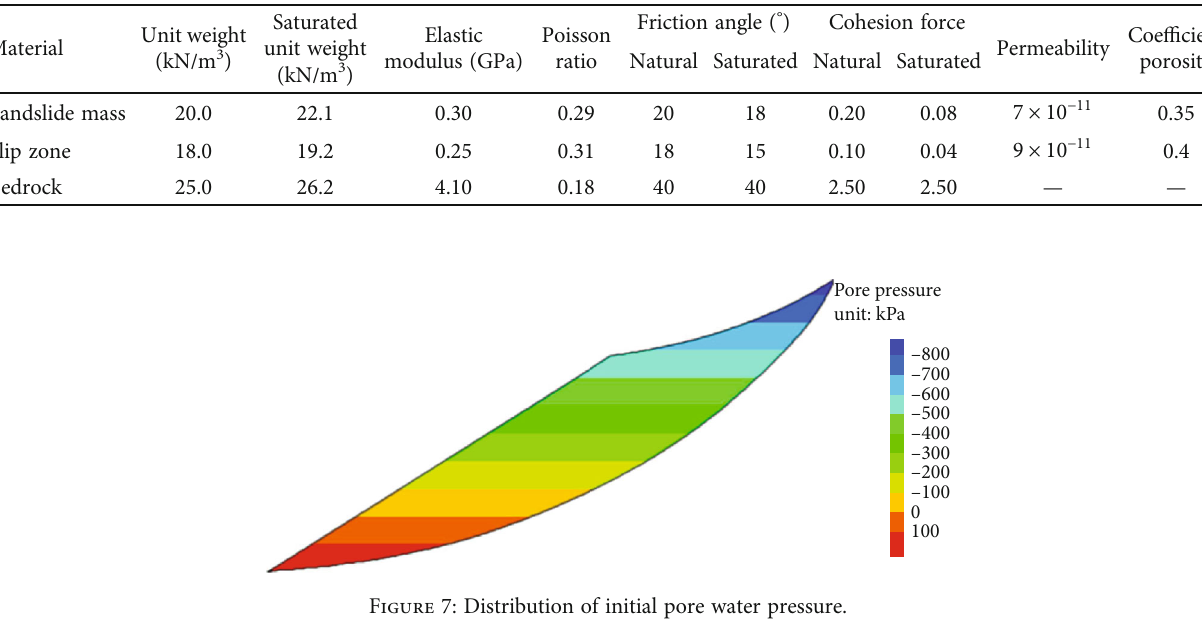
Table 1: Material parameters of the Erdaohe landslide.